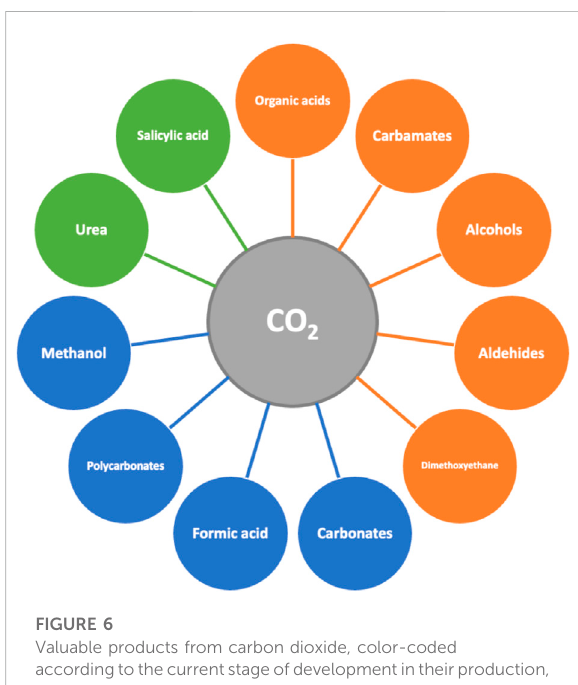
TABLE 3 Selected bio-based building blocks.